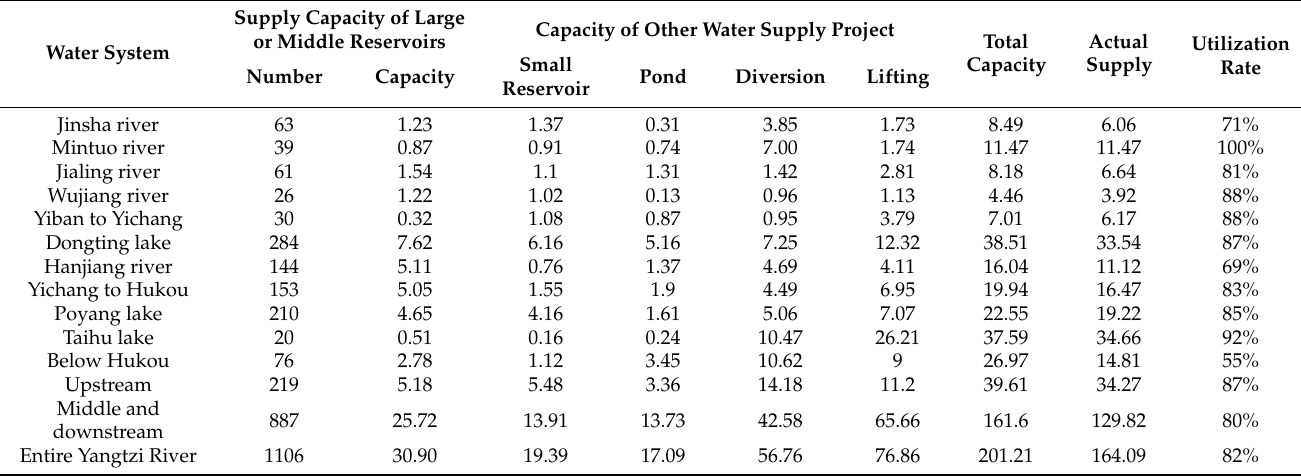
Table 2. Water supply capacity and actual supply amount in Yangtze River Basin in 2000 (Bm 3 ). Supply Capacity of Large or Middle Reservoirs Water System